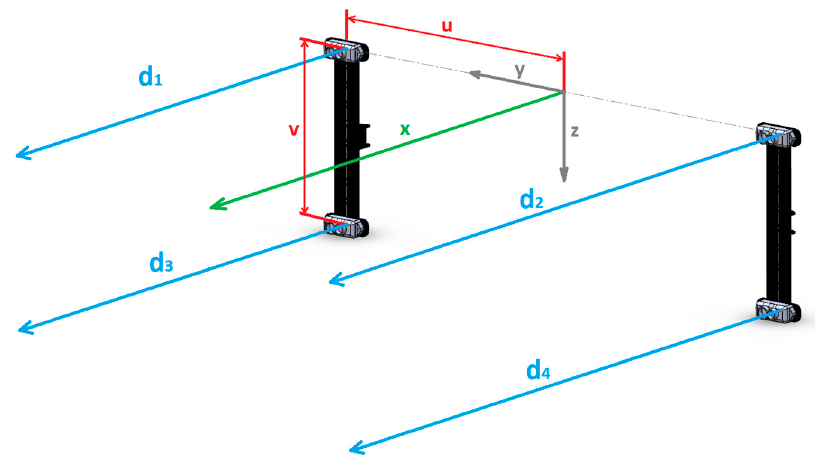
Figure 1. Frontal LIDAR-based range finders distribution in the UAV local reference frame. From Figure 1, s 1 = ( 0, u , 0 ) T , s 2 = ( 0, − u , 0 ) T , s 3 = ( 0, u , − v ) T , s 4 = ( 0, − u , − v ) T